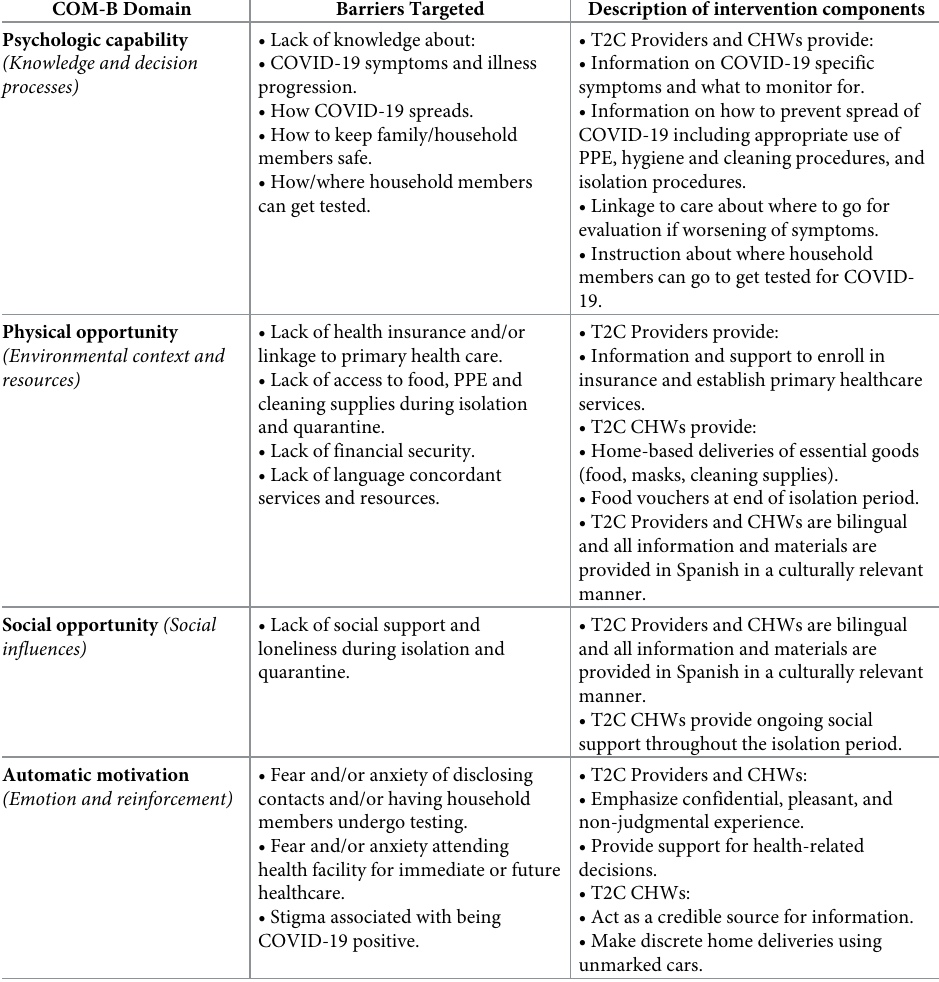
Table 1. Hypothesized barriers faced by low-income, Latinx COVID-19 positive individuals and description of intervention components to address potential